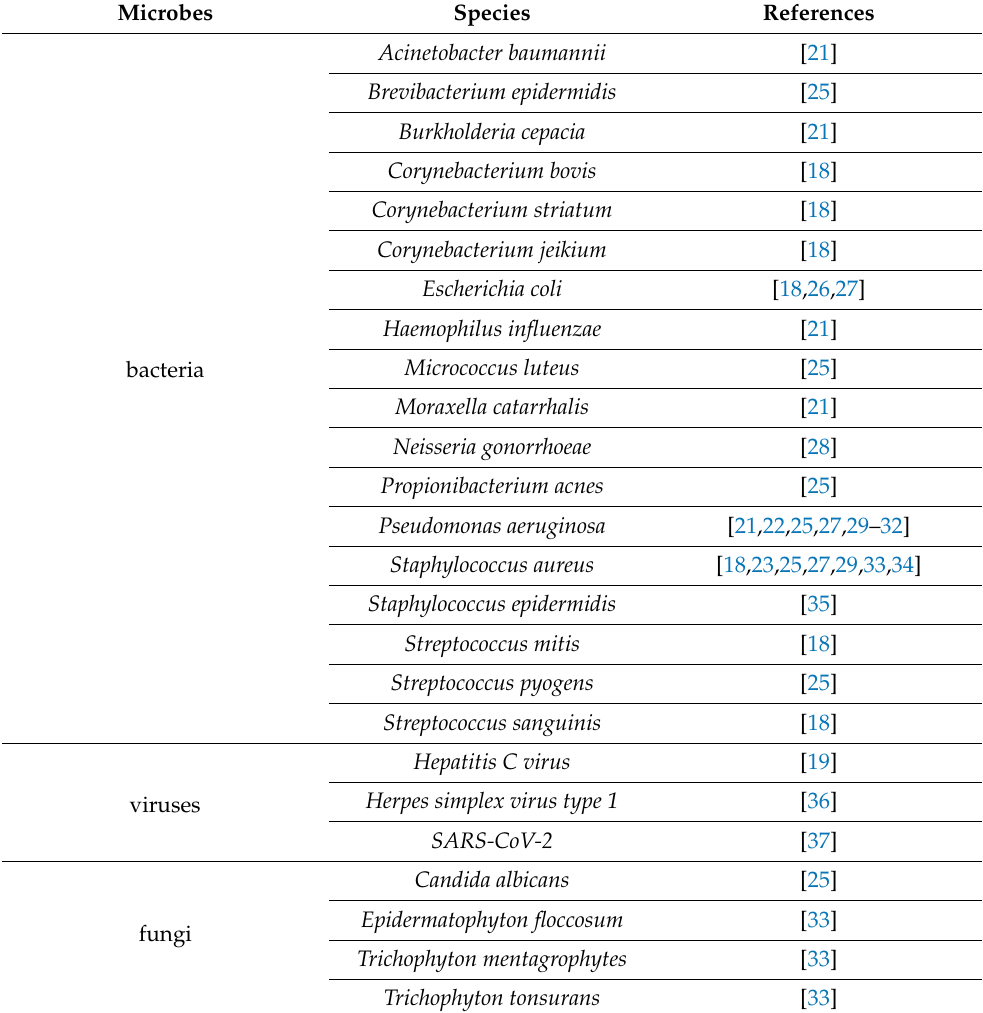
Table 1. Microbes attacked by